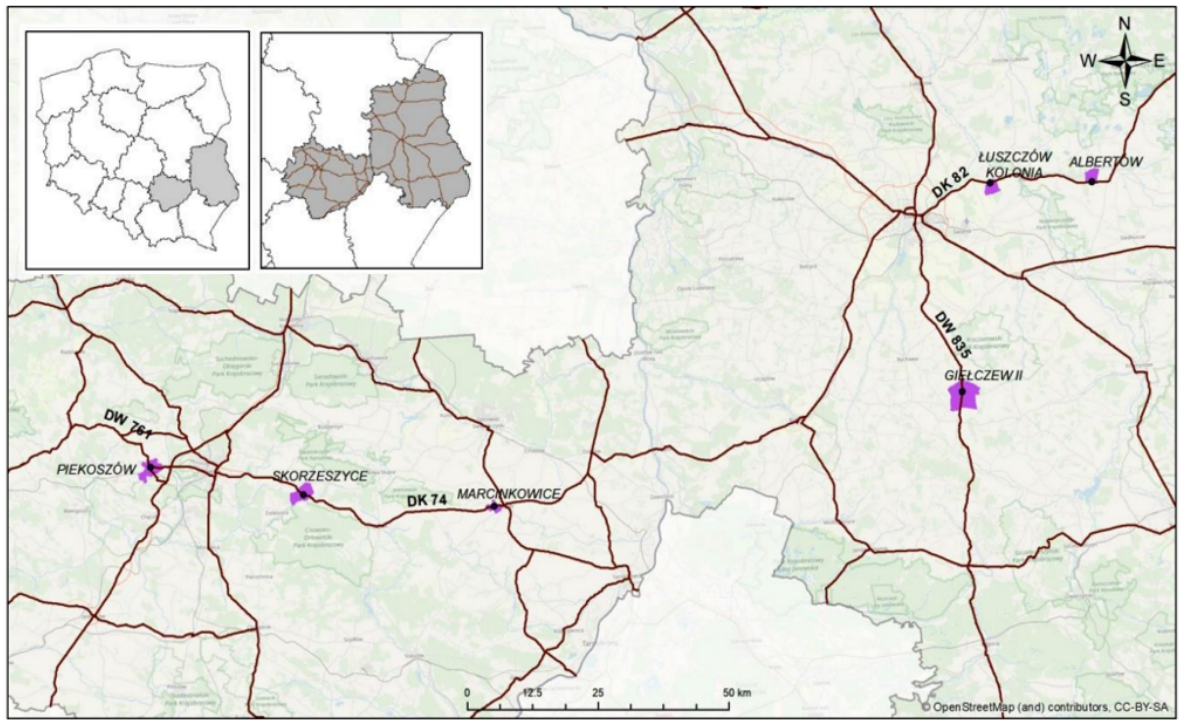
Figure 1. Location of the study area [28,29].